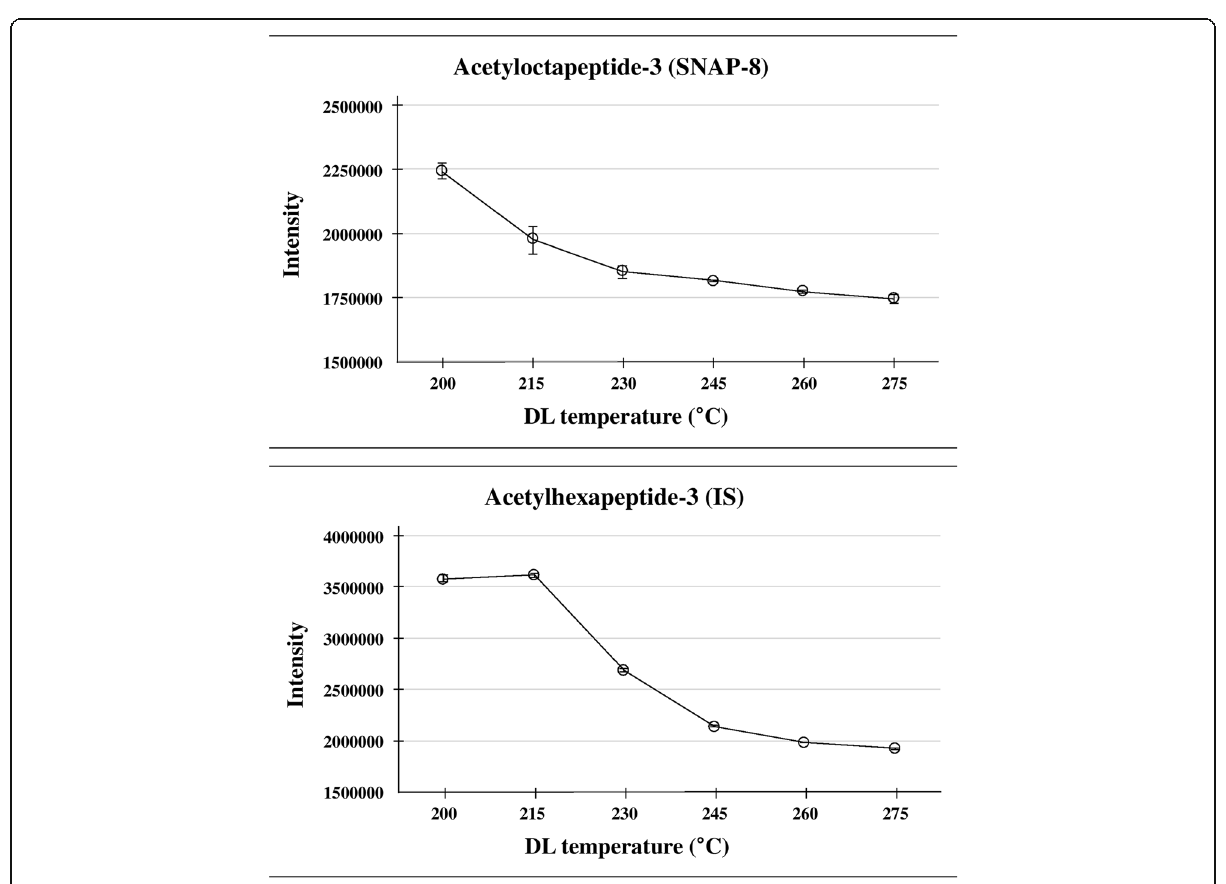
Fig. 2 Optimization of DL temperature in the range 200 to 275 °C